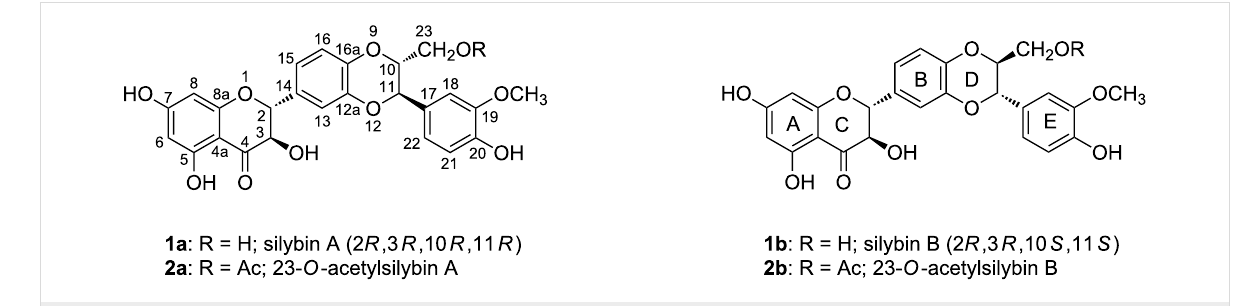
Figure 1: Selected naturally occurring trans -silybins and their acetates.